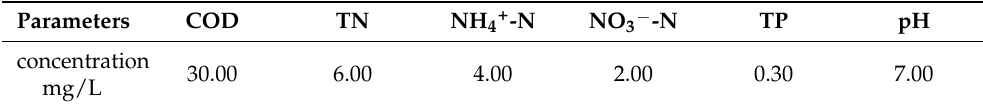
Table 1. Experimental water quality.